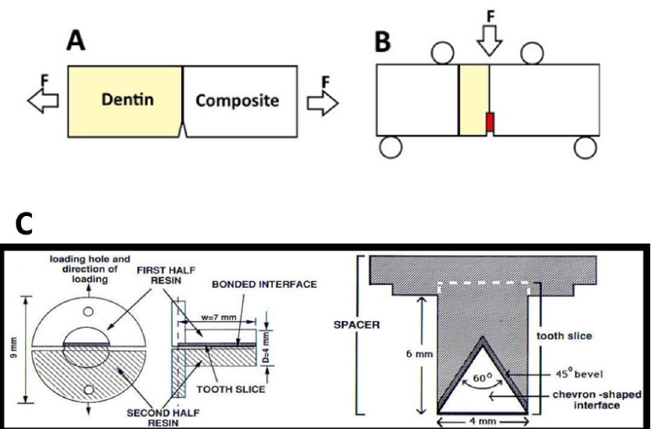
Figure 6. Simplified Specimen geometries for ( A ) a single edge notch beam test conducted. F represents the direction of force exert on the specimen. Modified from [54]. ( B ) An example of a single edge notch chevron beam test; the chevron created at the resin dentin interface is colored in red. Modified from [55]. ( C ) short rod chevron test, modified from [38].